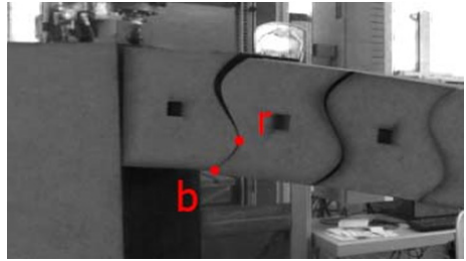
Fig. 27 Centres of rotation for the snake